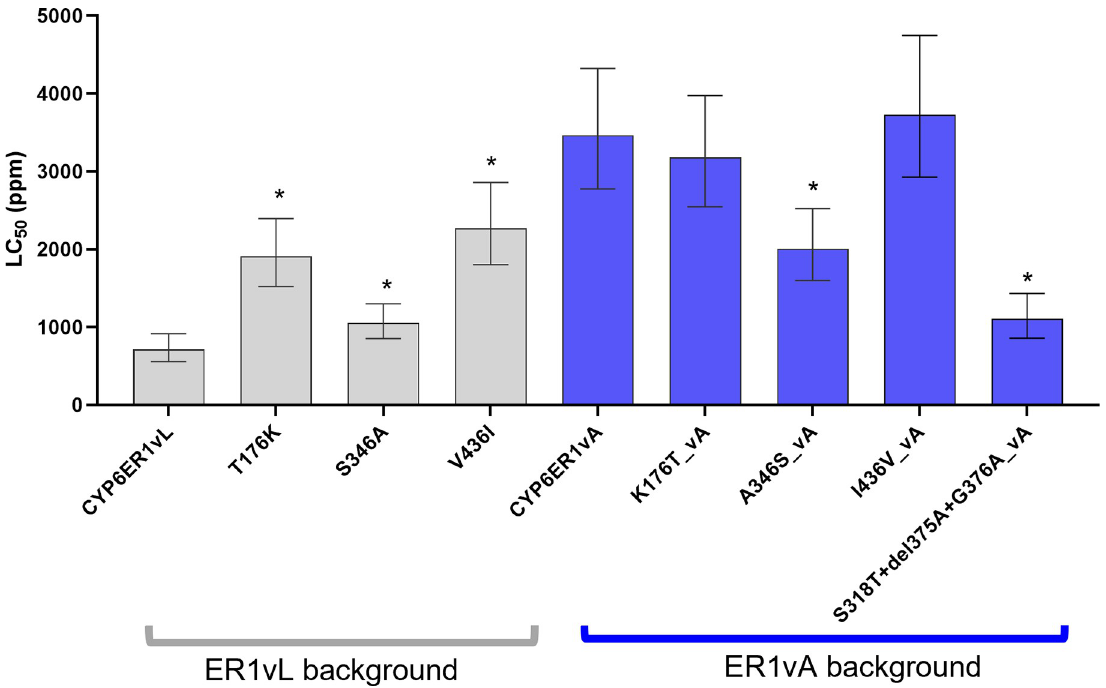
Fig 5. Sensitivity of transgenic strains of Drosophila melanogaster expressing mutated CYP6ER1 variants to imidacloprid. Lethal Concentration 50% (LC 50 ) values derived from full dose-response bioassays are displayed for D . melanogaster strains expressing CYP6ER1vL variants to which mutations found in CYP6ER1vA were added, or CYP6ER1vA to which mutations were removed. For comparison LC 50 values derived from flies expressing the wildtype versions of CYP6ER1vA and CYP6ER1vL are shown. Error bars show 95% CI (n = 4). Significant differences (p = < 0.05) in LC 50 values of fly lines expressing CYP6ER1 mutated variants and the respective wildtype fly line (CYP6ER1vA or CYP6ER1vL), identified by z- tests using the compParm() function of the ’drc’ package [36], are indicated using an asterisk above relevant bars. See also S7 Table.